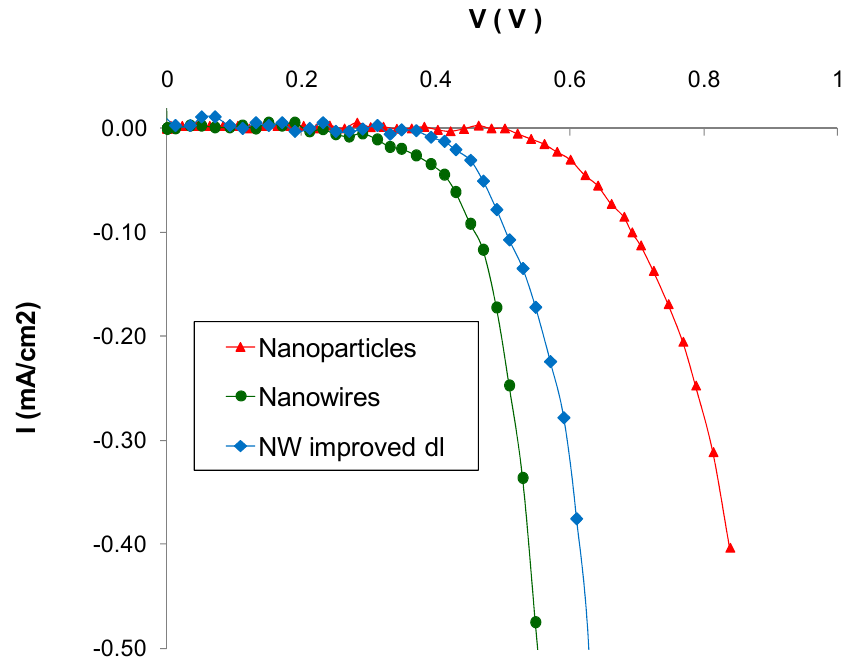
Figure 6. Dark current–voltage characteristics of ZnO nanoparticle, NW and NW with improved dye loading DSSCs.